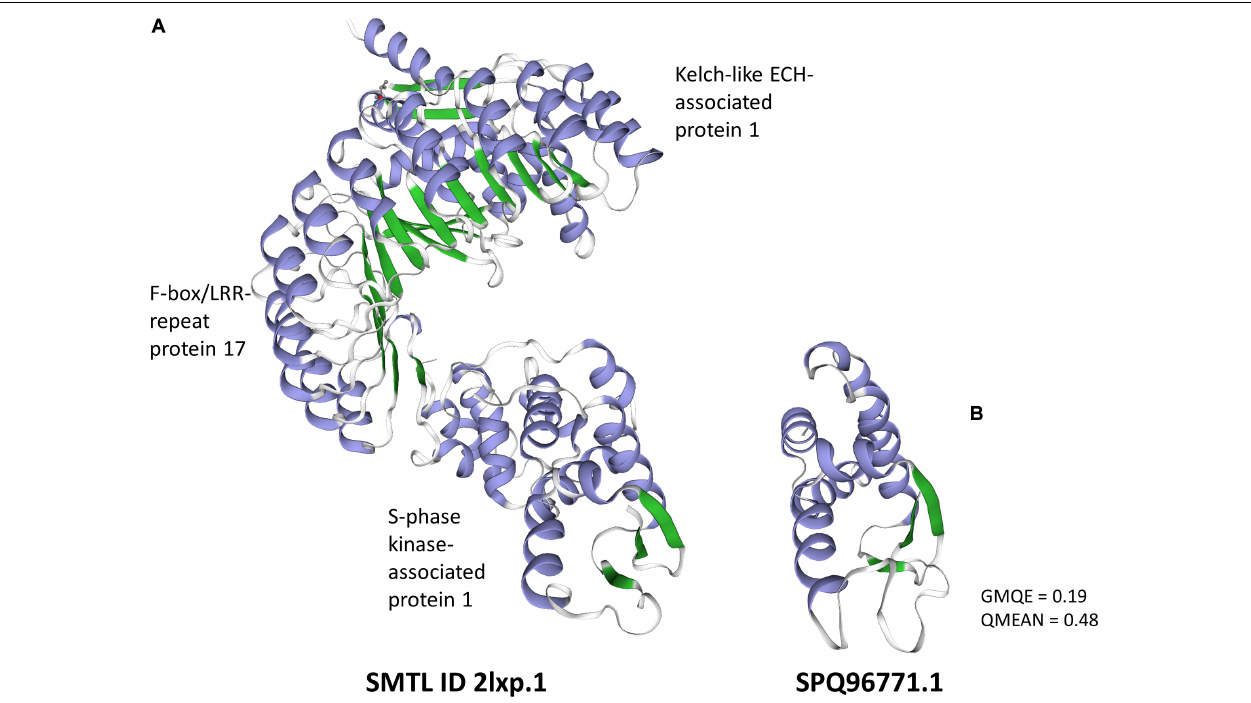
FIGURE 2 | Predicted 3D structure of S-phase kinase-associated protein 1. (A) The model or the heterotrimeric complex used as template. (B) The region corresponding to the S-phase kinase-associated protein 1 was predicted using Swiss-model. A Global Model Quality Estimation (GMQE) score closer to 1 represents more accuracy in the models, and a QMEAN value above –4 is indicative of good quality of the structure